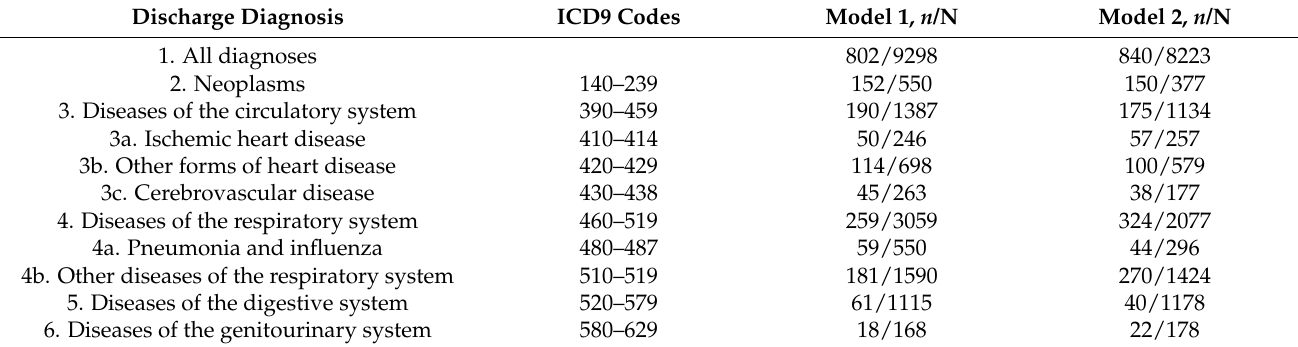
Table 2. Number of deaths ( n ) and hospitalizations (N) observed under organizational Models 1 and 2 for the set of discharge diagnoses